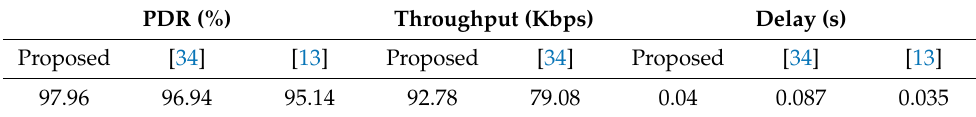
Table 8. Comparative parametric